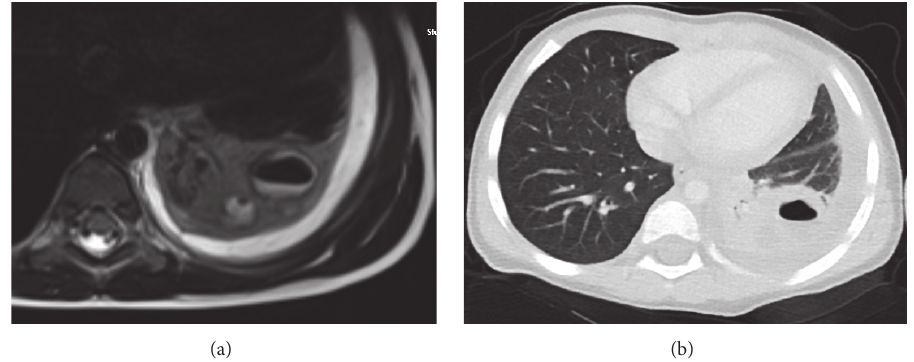
Figure 1: Thoracic vertebrae MR (a) and thorax CT (b) images: necrotizing pneumonia in the left lower lobe of lung.